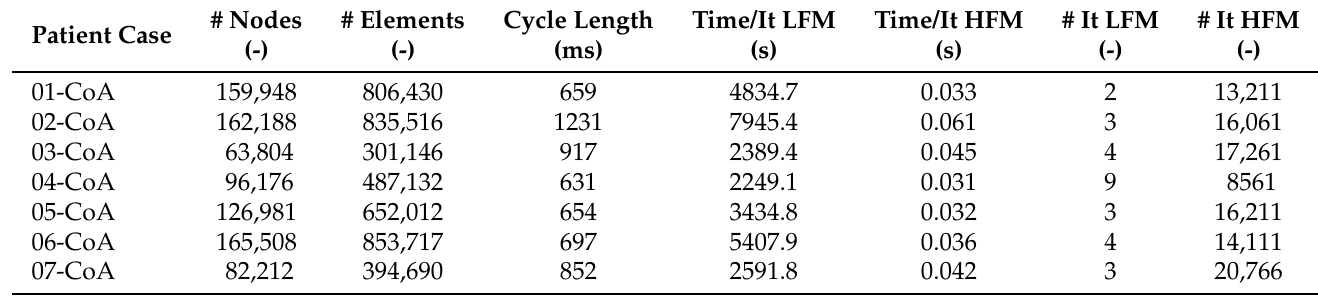
Table 1. Mesh information, CPU times, and iteration numbers for each patient case. Given is the number of nodes and elements of the patient-specific FE mesh, the cardiac cycle length, and the times per iteration and number of iterations for personalising the low-fidelity model (LFM) in the first step (3D EM model) and the high fidelity model (HFM) in the second step (0D EM model). 3D simulations in the first step were run on ARCHER2 using 128 cores and 0D simulations in the second step were run on a desktop computer using 1